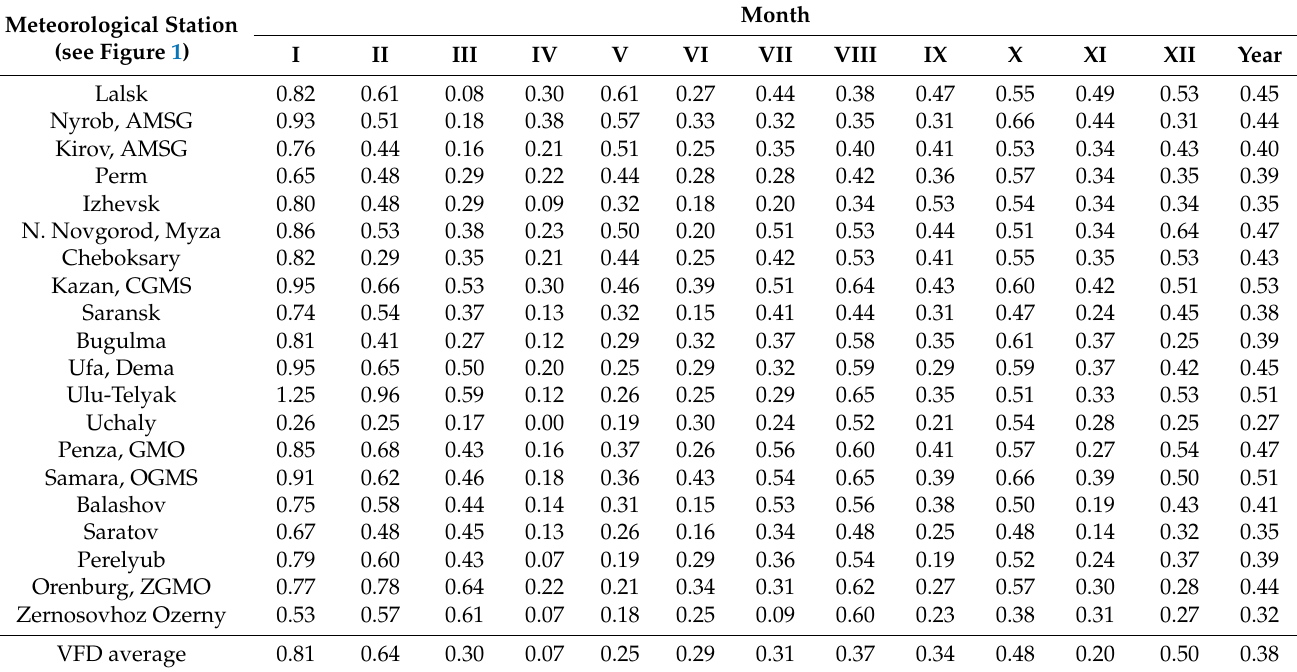
Table 2. Linear trend slope coefficients (LTSC, ◦ C/10 years) for monthly and annual average air temperatures in the Volga Federal District (VFD) during